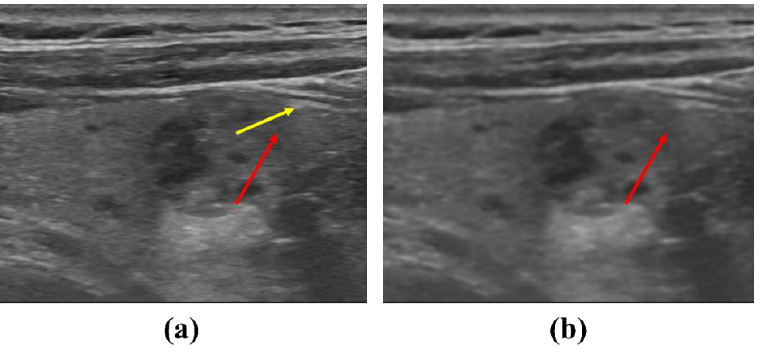
Figure 9. Ultrasound images to observe changes in the margin of the thyroid nodule: ( a ) noisy image and ( b ) NLM denoising with high smoothing. The red arrow means the actual exact nodule margin, and the yellow arrow means the margin that can be misunderstood.